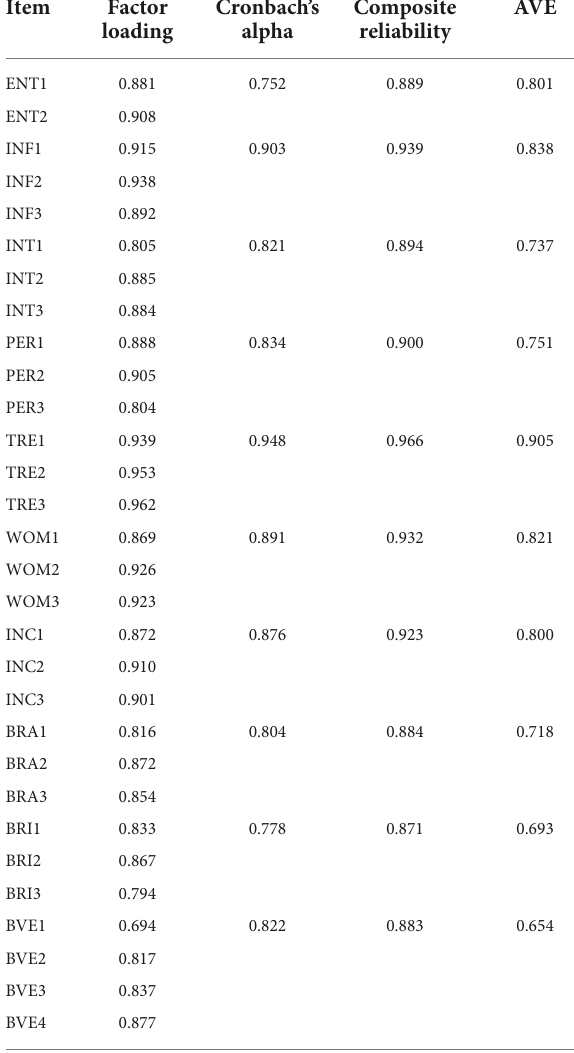
TABLE 5 Factor loading, construct validity, and